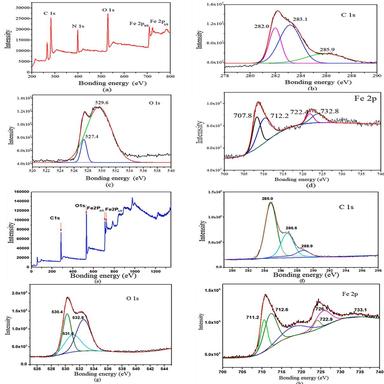
XPS spectra of (a-d) FG2I and (e-h) FG2E; (a and e) Shared examined region, (b and f) C 1 s region, (c and g) O 1 s region, and (d and h) Fe 2p region.